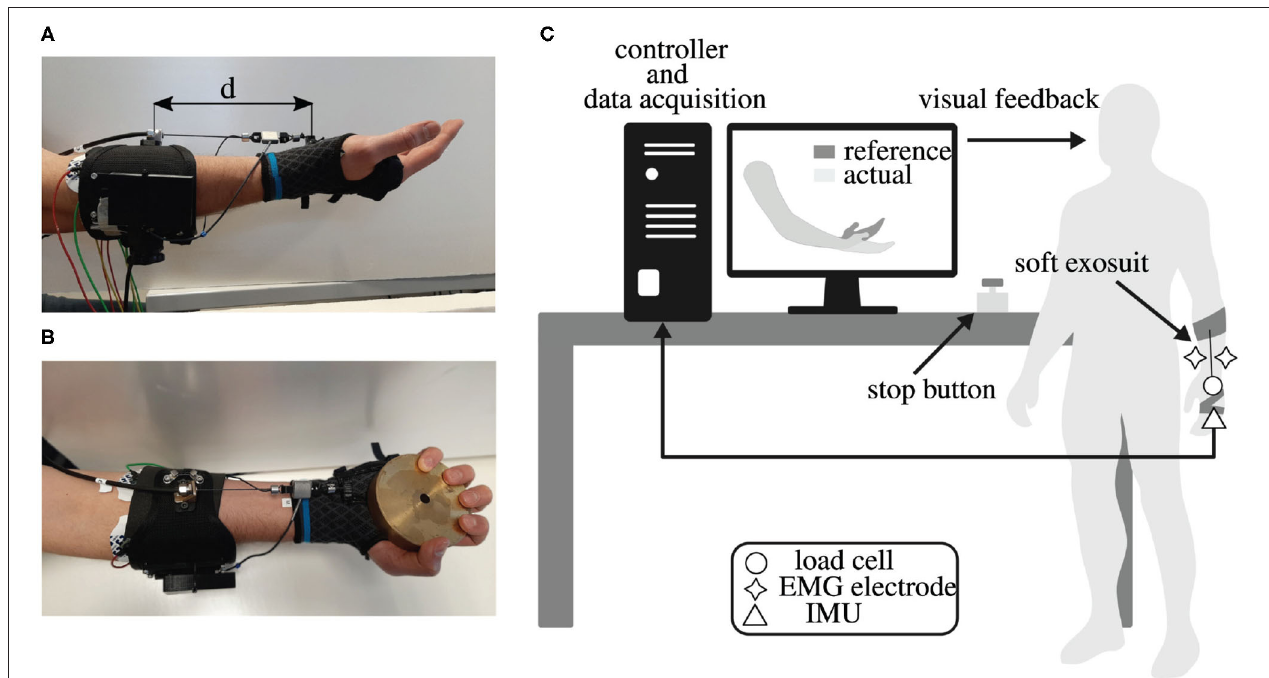
FIGURE 6 | Experimental setup. (A) In the transmission stiffness test, two infrared markers were positioned on the anchor point of the forearm strap and of the glove. The distance d between the two markers, identified by the arrows, has been used to evaluated the anchor point stretching [it is equal to d ( t ) − d 0 , where d 0 is the distance when no force was applied on the glove]. (B) During the isometric and the dynamic test, the user was asked to hold a 1.5 kg weight. (C) Subjects were asked to follow a reference trajectory displayed on a screen in the form of a moving hand, and the position of their own arm was superimposed to provide visual feedback. This was done in both the powered and unpowered conditions while monitoring the wrist flexion angle, the interaction force (only powered), and electromyography (EMG) activity of the four antagonistic muscles driving the joint.